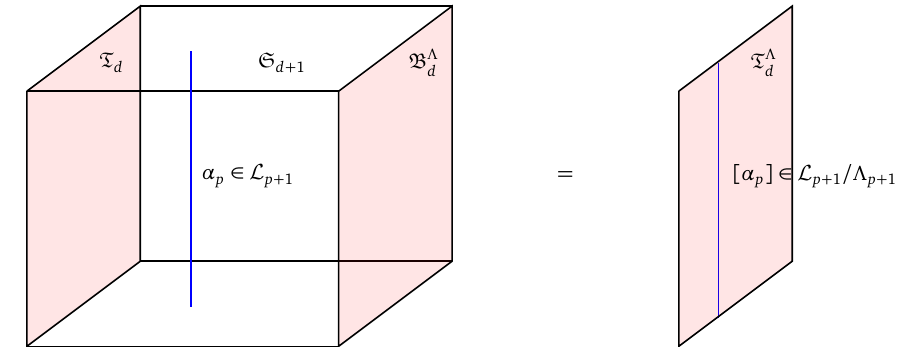
∈ L of the TQFT S p p + 1